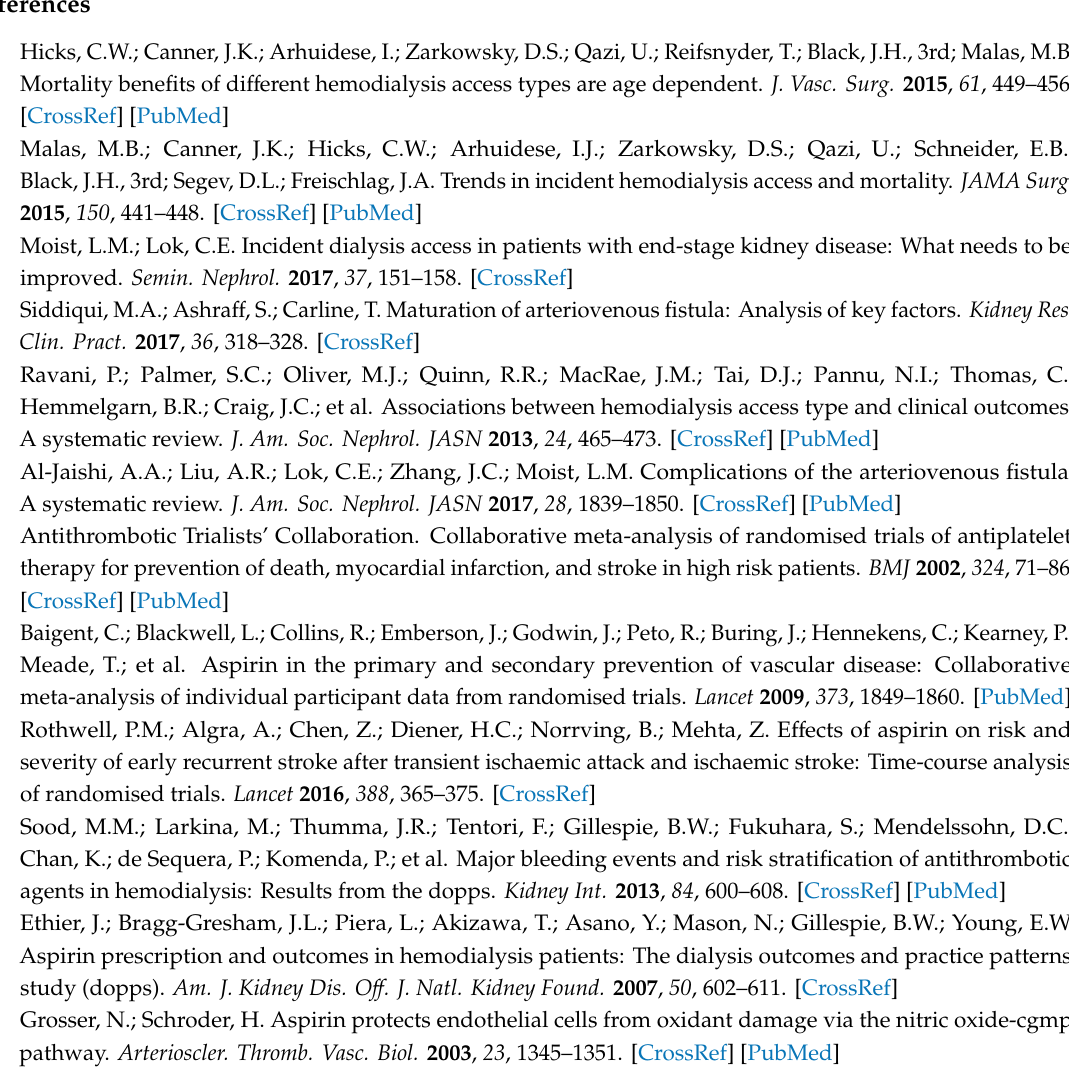
Table S1: Patients who were not using AVF or AVG within three months from the HD initiation, Table S2: Baseline clinical characteristics and biochemical variables of the study population according to baseline aspirin use after propensity score